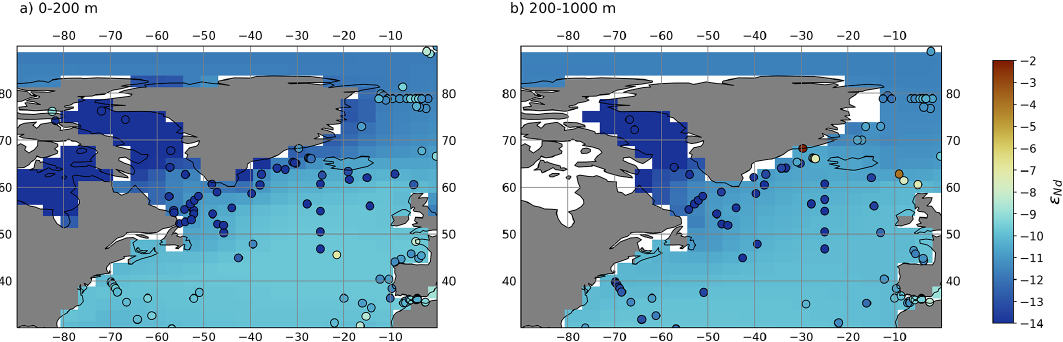
Figure 17. Volume-weighted distributions of ε Nd in simulation EXPT_SED2 split into two different depth bins, (a) shallow (0–200m) and (b) intermediate (200–1000m), within the North Atlantic and Labrador Sea basins. Water column measurements from within each depth bin (Osborne et al., 2017, 2015; GEOTRACES Intermediate Data Product Group, 2021) are superimposed as filled circles on the same colour scale. Note that Iceland is not resolved in FAMOUS (Jones,